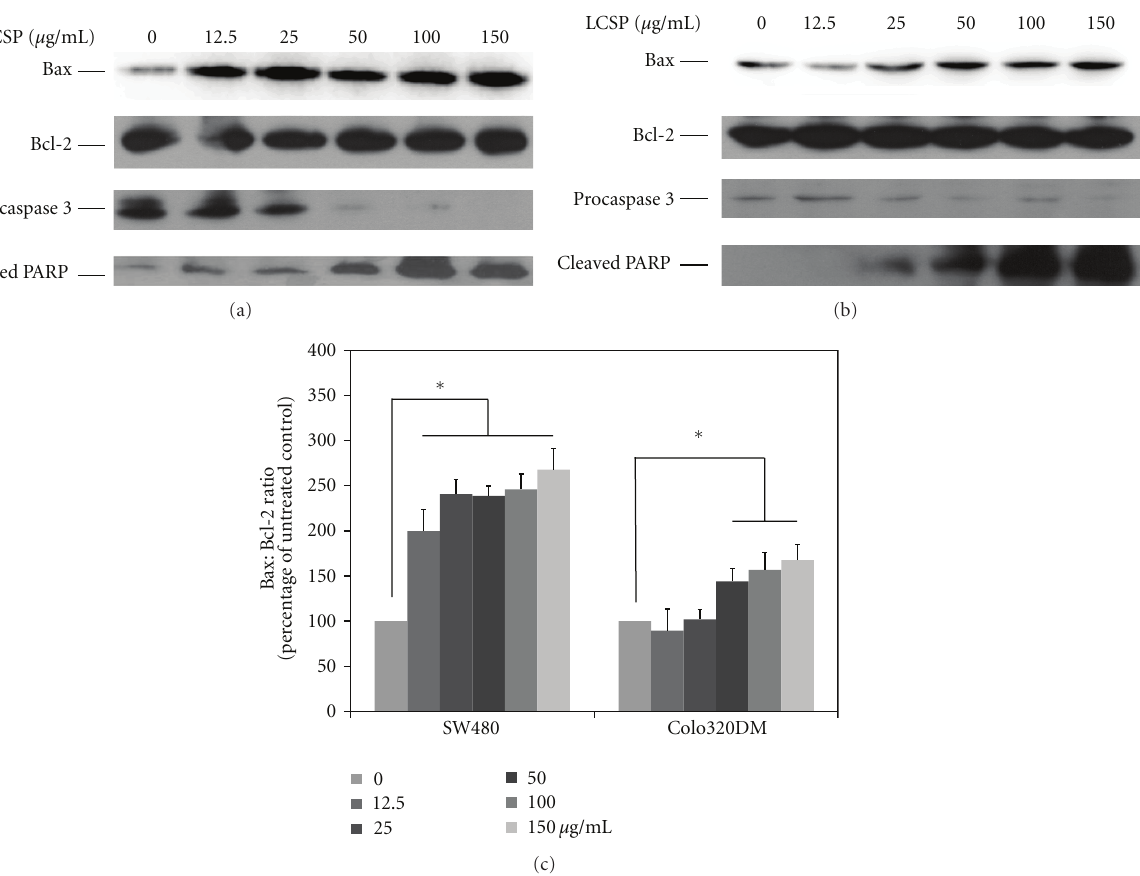
Figure 5: Immunoblots of apoptosis-controlling proteins in LCSP-treated colorectal carcinoma cells. The cell lysates from LCSP-treated SW480 (a) and Colo320DM (b) were separated by SDS-PAGE, transferred to PVDF membranes, and immunoblotted to show the levels of Bax, Bcl-2, procaspase 3 and cleavage-PARP. The protein levels of Bax and Bcl-2 were quantified using ImageJ software according to the density of each band on the immunoblotting image, normalized to the reference band ( β -actin), and presented as the fold of the untreated control. (c) The data reported are the averages of three independent experiments and are expressed as means ± SD. ∗ Represents a significant di ff erence ( P < 0 .